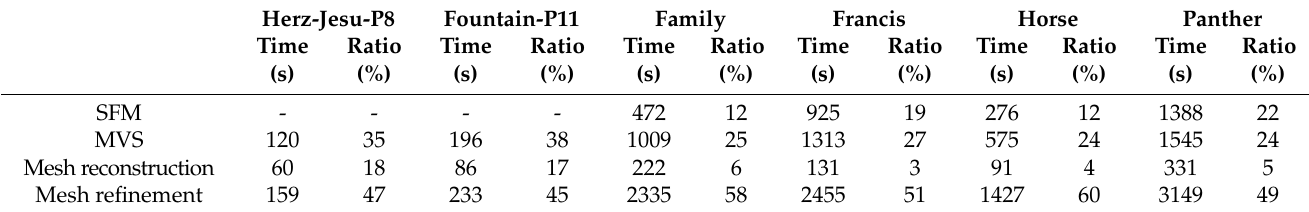
Table 5. The processing times of the 3D reconstruction system.